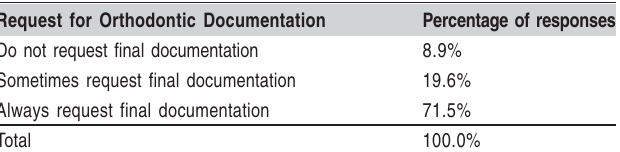
Table 1. Distribution of results relative to the request for final